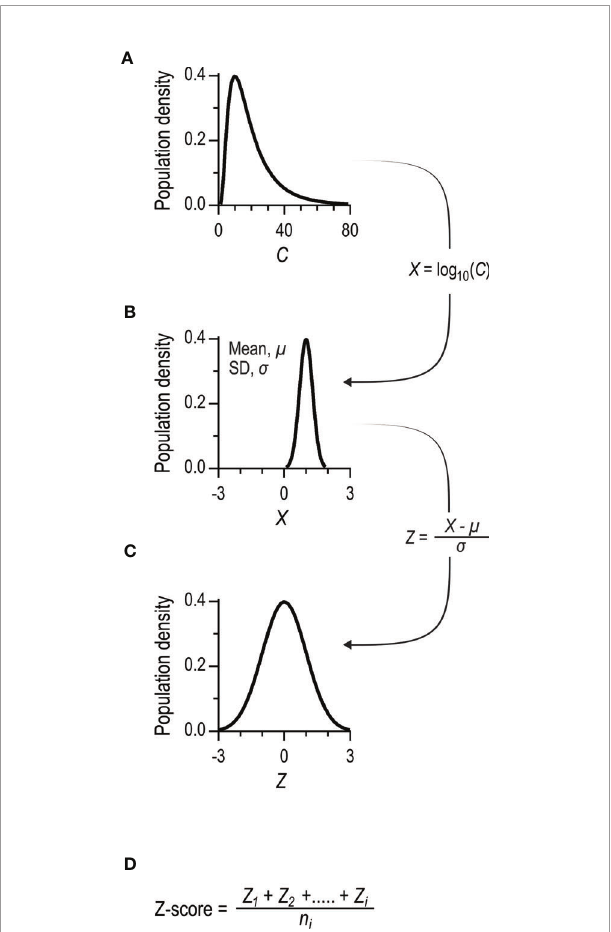
FIGURE 2 | Principles for calculating Z-scores. (A) The distribution of serum concentrations of a serotype-speci fi c antibody in a population. The distribution is typically left-skewed. (B) Log 10 transformation of data results in Gaussian distribution. (C) The individual concentrations are further transformed to standard normal distributions. This is achieved by subtracting the mean and dividing by the standard deviation of the population dataset. The fi nal parameter is dimensionless, and the population data set has a mean of 0 and a standard deviation of 1. (D) The Z-score is calculated for each patient as the mean of the standard normal deviations of the individual antibody levels. The Z-score´s standard deviation tends to decrease with an increasing number of distinct serotype-speci fi c antibody levels, owing to mutual correlations (10). To promote comparability of cohorts tested with different number of measured serotype- speci fi c antibody levels, the Z-score is normalized by the standard deviation of the population